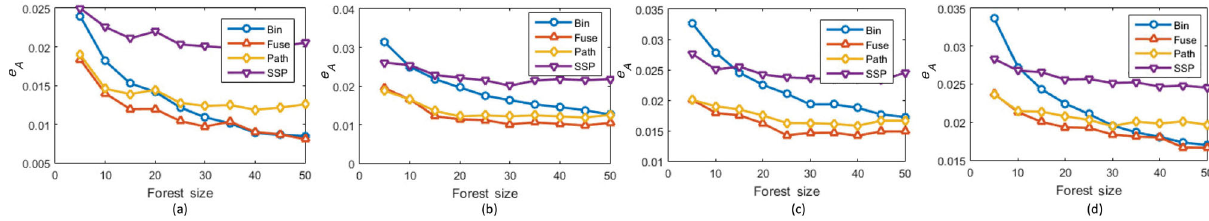
Fig. 4 Affinity matrix difference e A for the combined forest-based metric (Fuse), the binary metric (Bin), the common-path-based metric (Path), and the SSP-based metric for four toy datasets: (a) corner , (b) puncturedsphere , (c) twinpeaks , and (d) 3 D clusters .